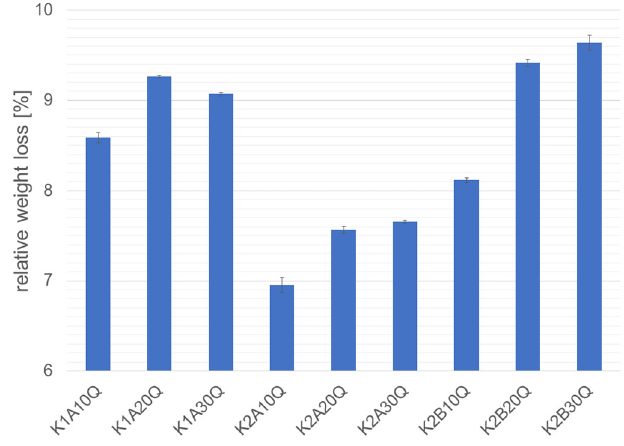
Figure 11. Relative weight loss of potassium water glasses with aluminum metaphosphate hardeners after treatment in hot sulfuric acid according to testing norm DIN 51-102 Part 1. Samples with 30wt% of potassium water glasses K1 and K2 (alkali modulus K1 < K2), and 10-30wt% of aluminum metaphosphates A = aluminum tetrametaphosphate, Al 4 (P 4 O 12 ) 3 and B = aluminum hexametaphosphate, Al 2 P 6 O 18 , and 70wt% quartz as filler [22].